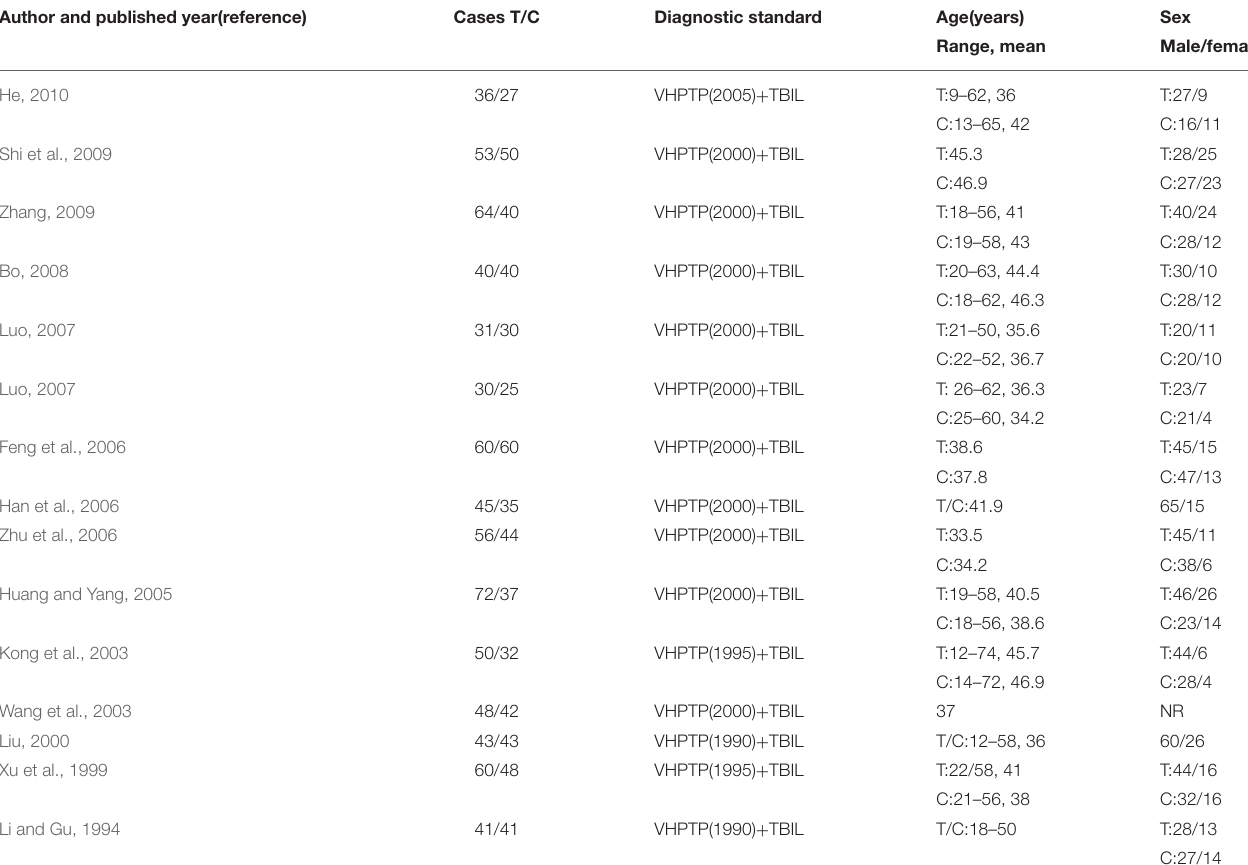
TABLE 1 | Characteristics of included